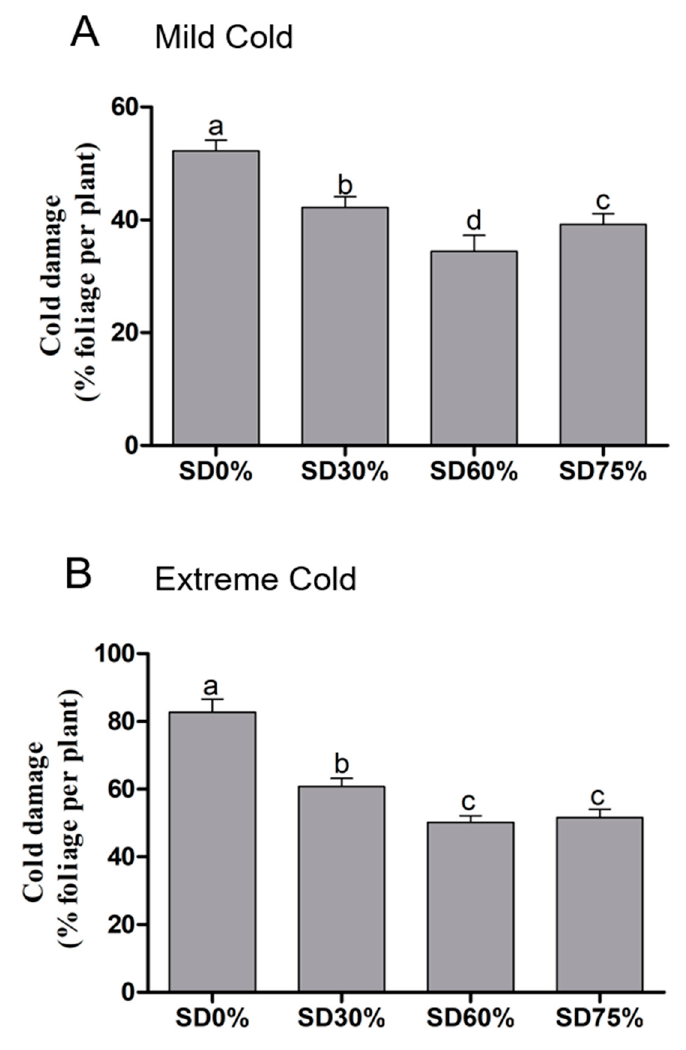
Figure 3. Effects of shading nets on cold-damage symptoms of tea leaves during ( A ) mild cold and ( B ) extreme cold conditions. Different letters on the top of the columns within each figure represent significant differences between the treatments indicated by LSD test at p <